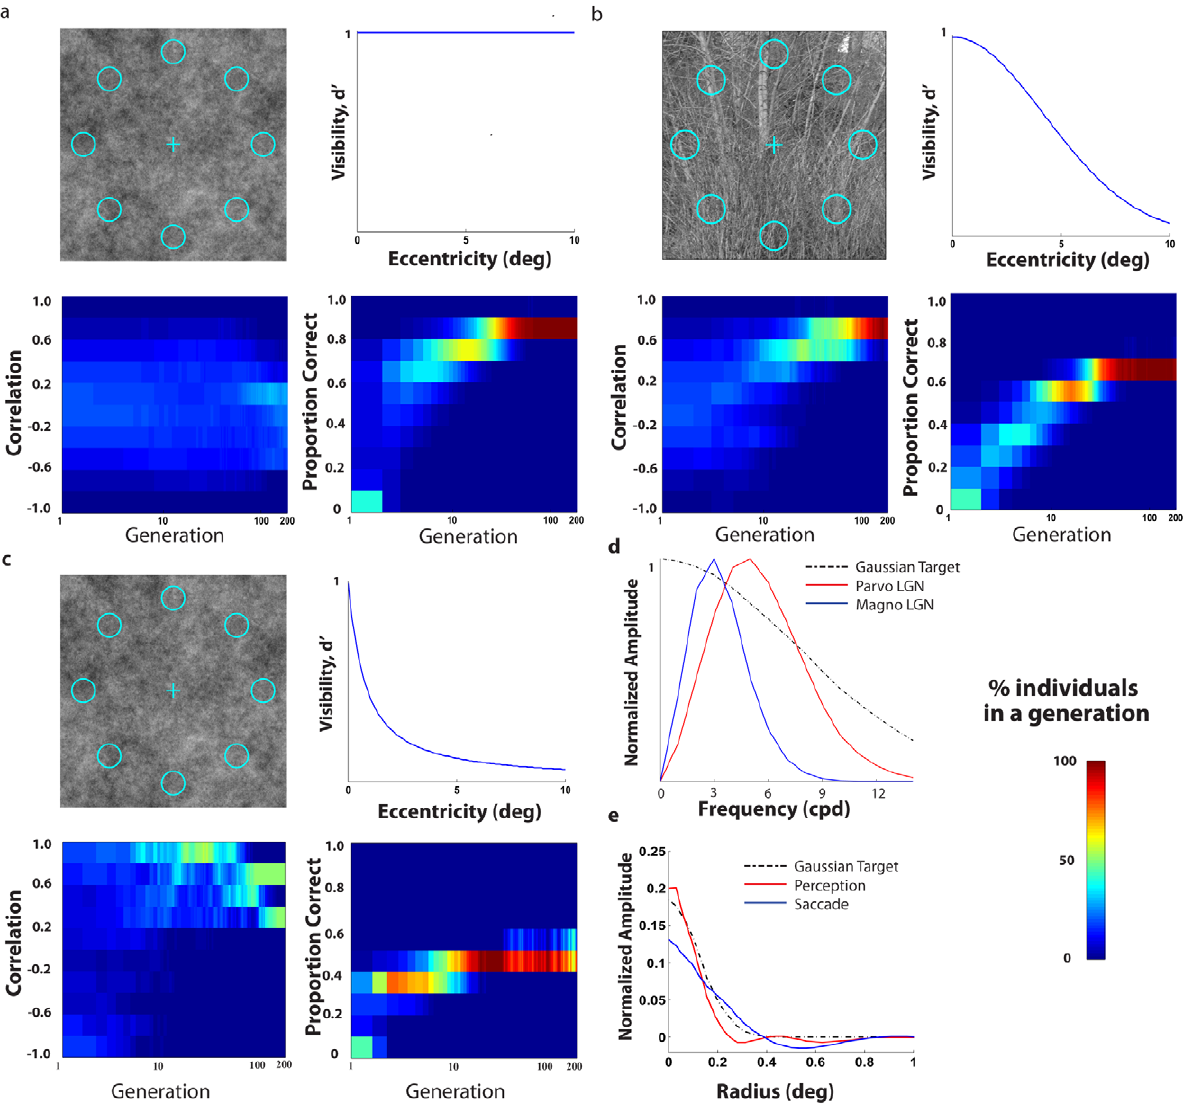
Figure 6. Evolution plots for scenarios which resulted in partial or no convergence of two templates. All proportion correct and correlation plots shows the distribution for individuals in each generation. All results based on averages across 10 virtual evolution runs. a. 8 AFC search of the elongated Gaussian signal for a flat visibility map (ELM model); b. 8 AFC search of the elongated Gaussian signal for a broad visibility map, natural images, but with 8 eye movements which allows the model to fixate on all possible target locations (ELM model); c. 8 AFC search of an isotropic Gaussian signal for a steep visibility map using 1/f noise for the ELM model and considering two visual processing streams with different spatial pre-filtering based on LGN parvocellular and magnocelluar properties; d. Normalized frequency amplitude for Gaussian target, parvocellular LGN cell and magnocellular LGN cell; e. Perception and saccade templates radial profiles (averaged across all angles) of best performing simulated individual for the model with pathway LGN